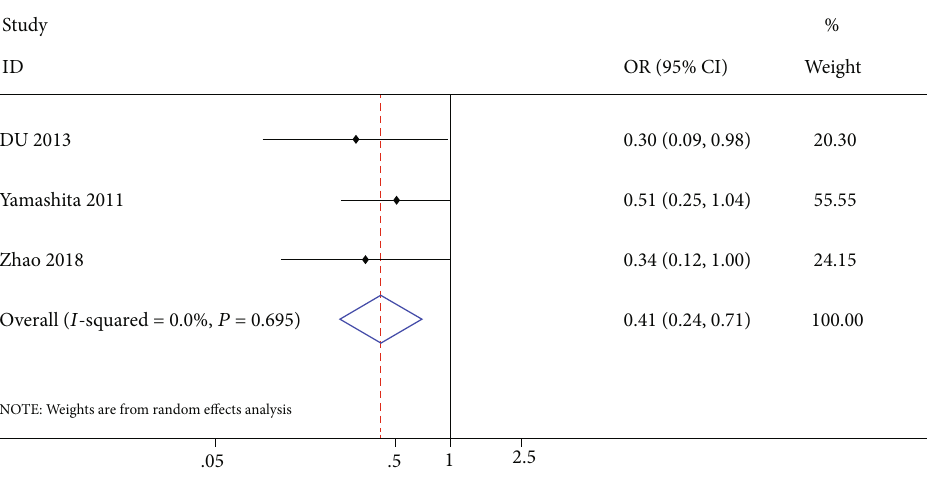
Figure 4: Forest plot of studies assessing the persistent AF rate among patients with hypertension and atrial fi